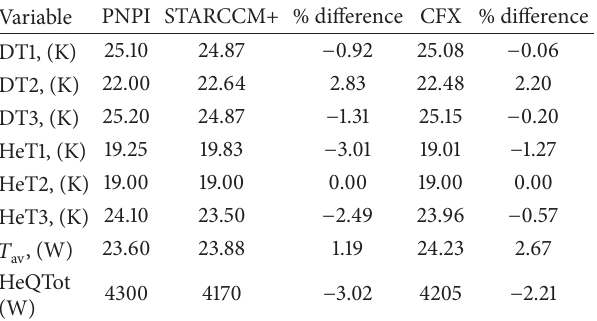
Table 2: Comparison between measurements and predictions by the CFD models of ANSYS CFX and STARCCM+ for nominal power of 4000